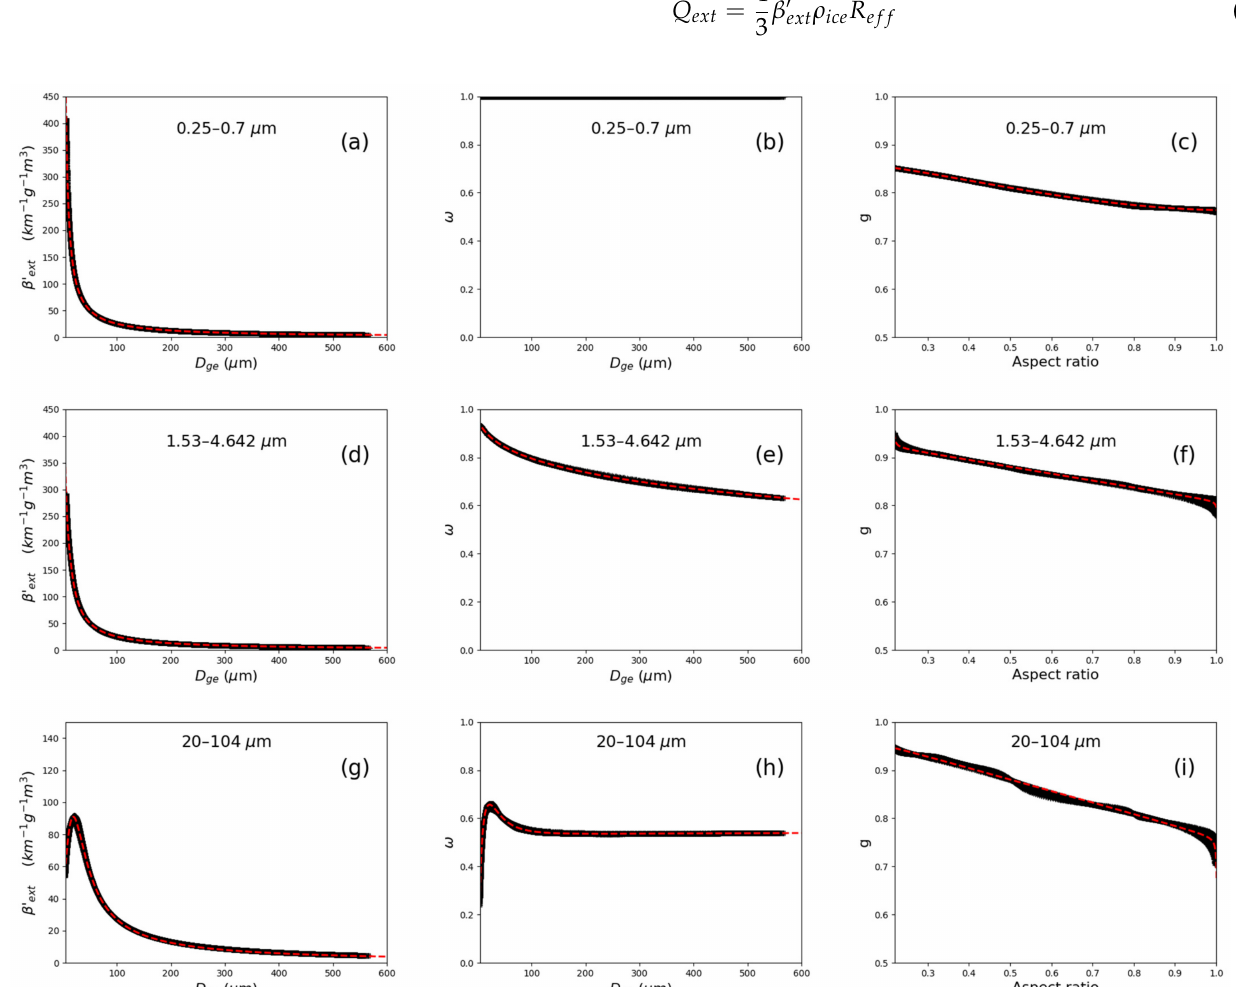
Figure 1. Parametrizations for β (cid:48) ( a , d , g ), single scattering albedo ( b , e , h ), and asymmetry factor ( c , f , i ) of hexagonal ice ext particles. The upper, middle, and lower rows refer to wavelengths of 0.25–0.7 µ m (SW) ( a – c ), 1.53–4.64 µ m (SW) ( d – f ), and 20–104 µ m (LW) ( g – i ), intervals respectively. The black line is composed of 7500 individual points, each represents a different particle-size distribution (PSD), and the red dashed line denotes the parametrization fit model. Notice the scale difference between ( a , d , g